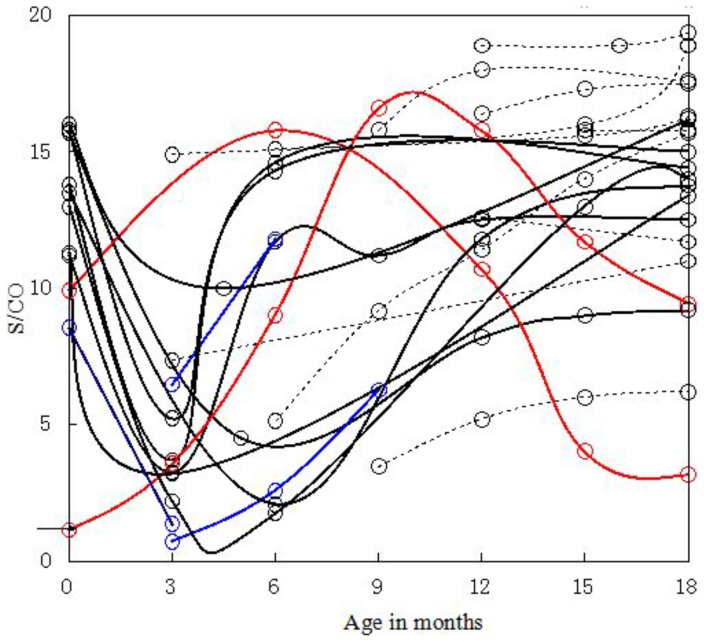
Anti-HIV S/CO values of infected infants at individual level.Black lines indicate the initial decrease and subsequent increase in S/CO; red lines indicate the initial increase and subsequent decrease in S/CO; blue lines indicate infants who died of HIV infection; and dotted lines indicate other infants. The figure was derived from 85 DBSs of 24 infected infants. The arrow indicates S/CO = 1.